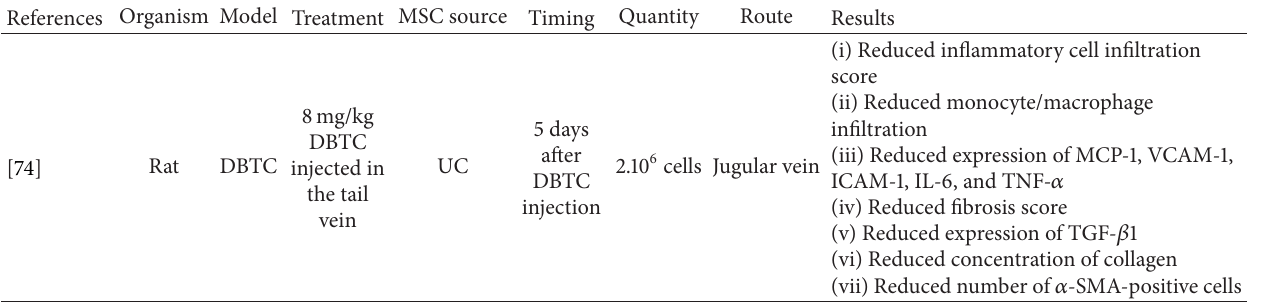
Table 6: MSC treatment on a preclinical pancreas fibrosis